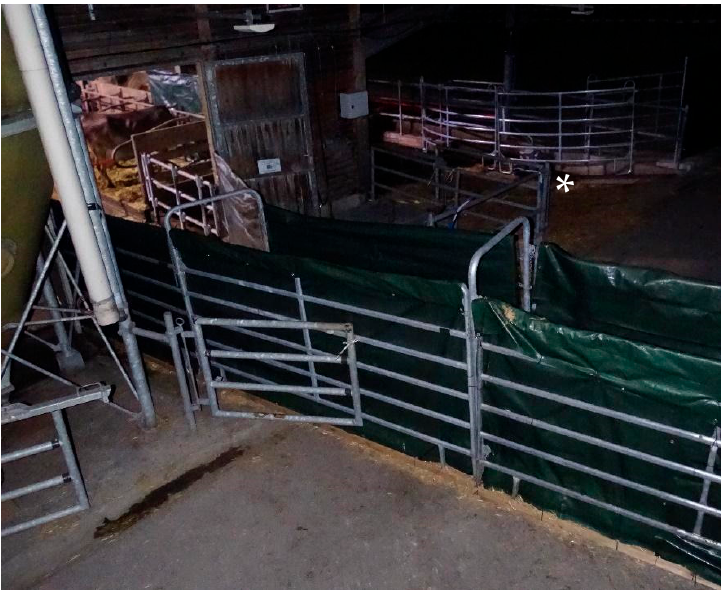
Figure 1. Race for NonH-R, covered with opaque weatherproofing tarpaulin. In the background, the exit of NonH is visible (*). The exit of HABIT would be to the left.